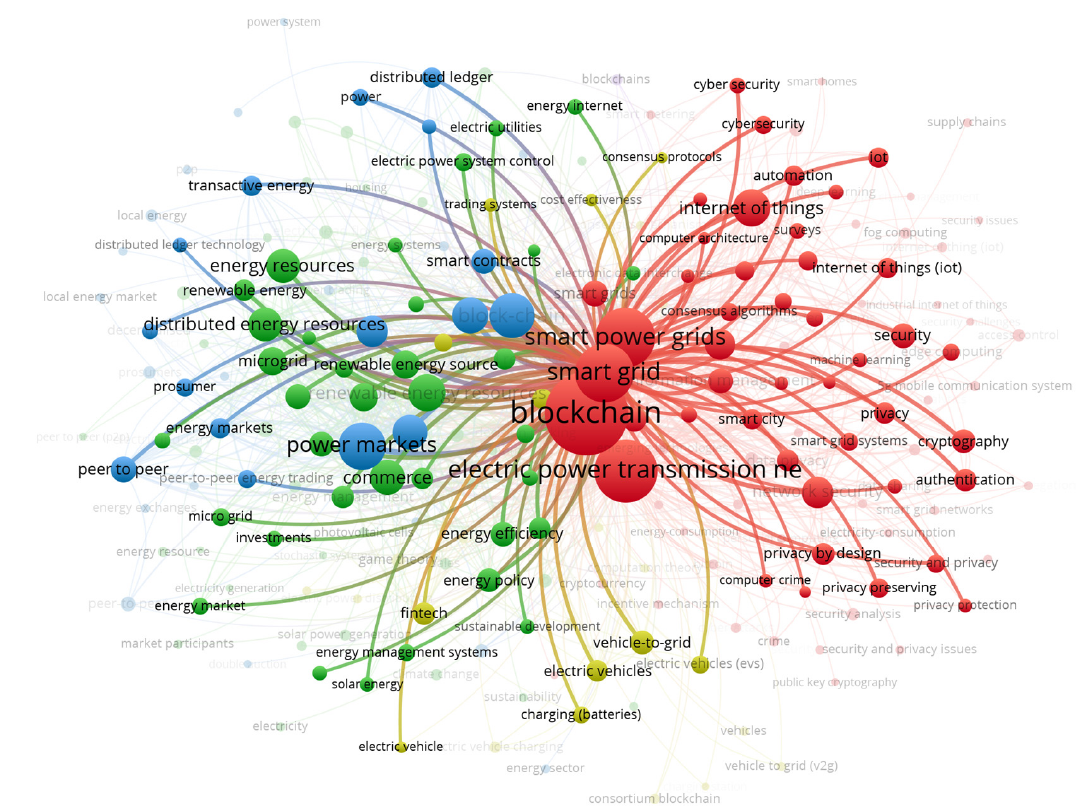
Figure A1. Keyword co-occurrence analyses (using VOS Viewer)—three views.